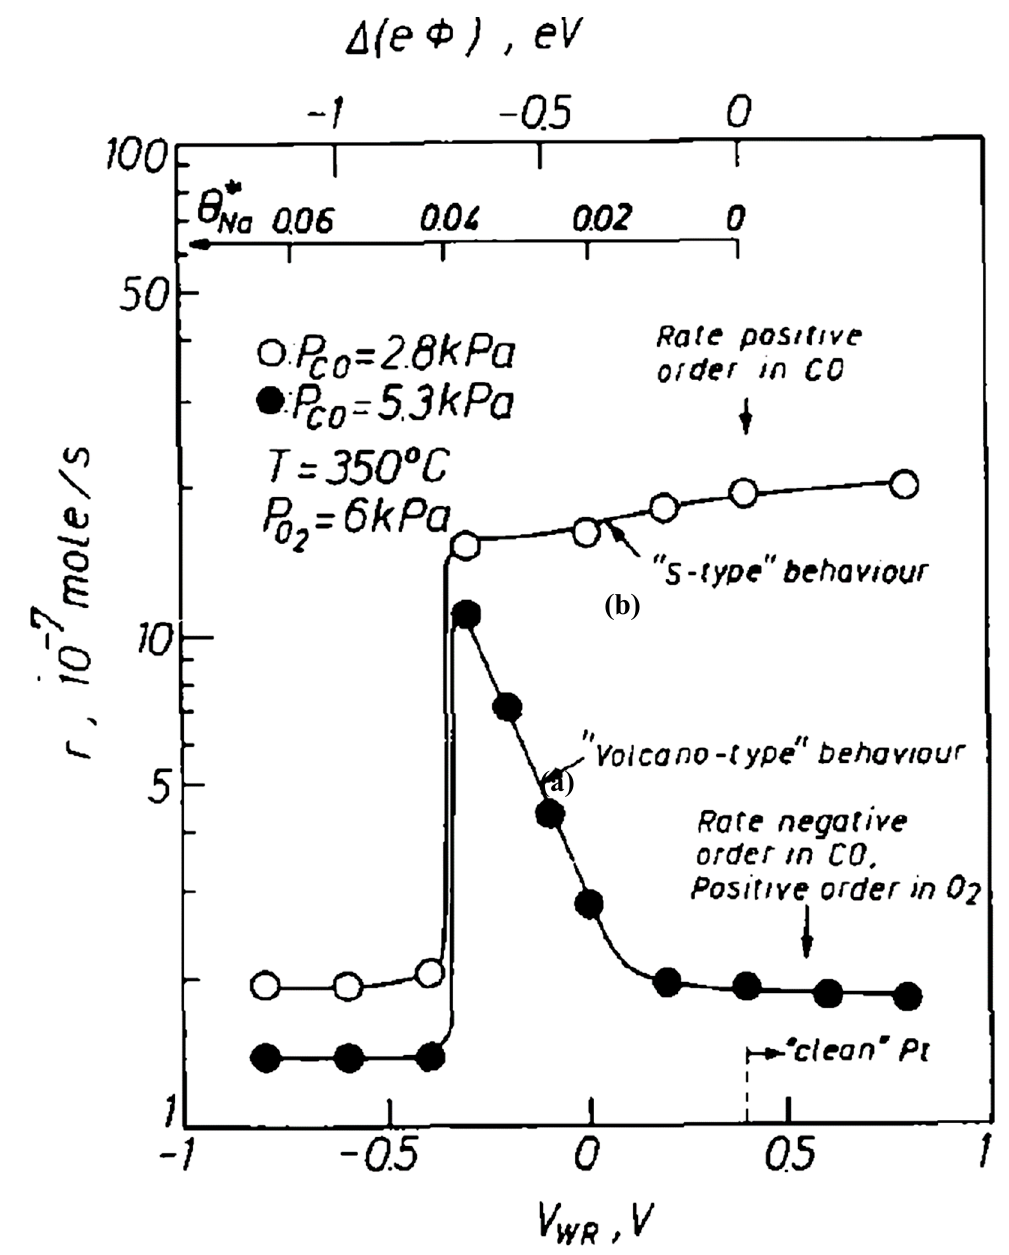
Figure 5. Effect of Na coverage θ Na on the rate of CO oxidation at oxygen lean (a: T = 350 ◦ C, [O 2 ] = 6%, [CO] = 5.3%; filled symbols) and at oxygen rich (( b ): T = 350 ◦ C, [O 2 ] = 6%, [CO] = 2.8%; open symbols) conditions. The volcano type behaviour upon increased Na coverage is obvious in case ( a ). Data was acquired in a Pt/(Na) β ”Al 2 O 3 /Au galvanic cell (Reprinted with permission from Ref. [16]; Copyright 1994, Elsevier).